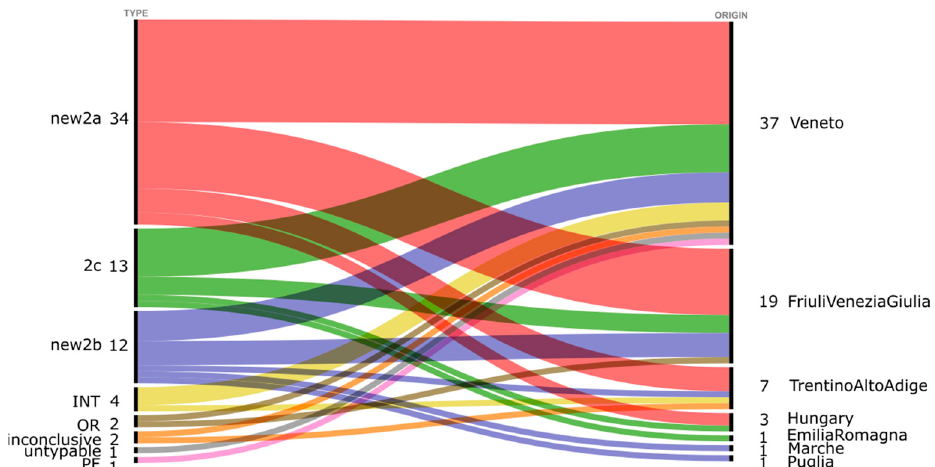
Figure 2. Alluvial plot of CPV-2 variants divided by region of origin. The left side of the diagram shows the CPV-2 variants identified in the present study: CPV-new2a (new2a-red), CPV-new2b (new2b-blue) and CPV-2c (2c-green), CPV-2 INT (Intervet Vaccine-yellow), CPV-2 OR (OR-brown) and CPV-2 PF (PF-purple). Inconclusive (orange): no consensus sequence obtained; untypable (grey): reported as untypable. The right side shows the geographic origin of CPV-2-positive samples. The width of the colored bands linking CPV-2 strains and region of origin is proportional to the number of isolates of each CPV-2 strain from each region of origin.